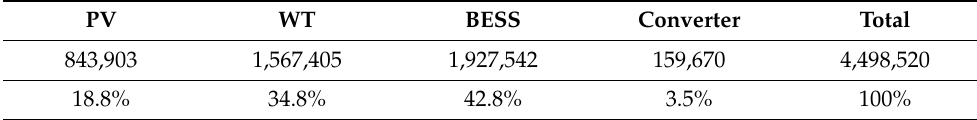
Table 11. Cost structure of topology_B by components (unit: USD).